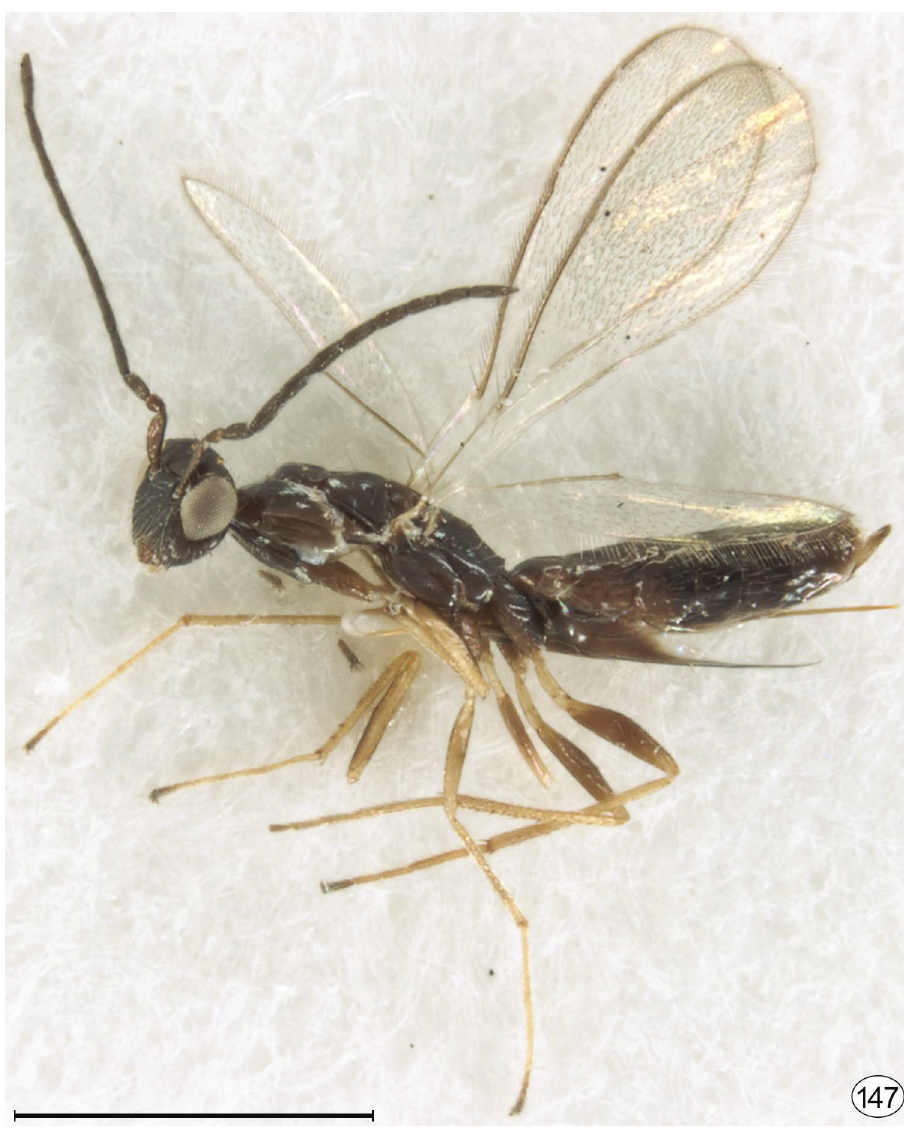
Figure 147. Neotriadomerus sp. 3, female habitus, lateral (Australia, NSW, Kosciusko National Park, Leather Barrel Creek, 0.8 km SW. Picnic Area, 36°32'S, 148°11'E, 1080m, 7–21.ii.1993). Scale bar = 1000 μm.